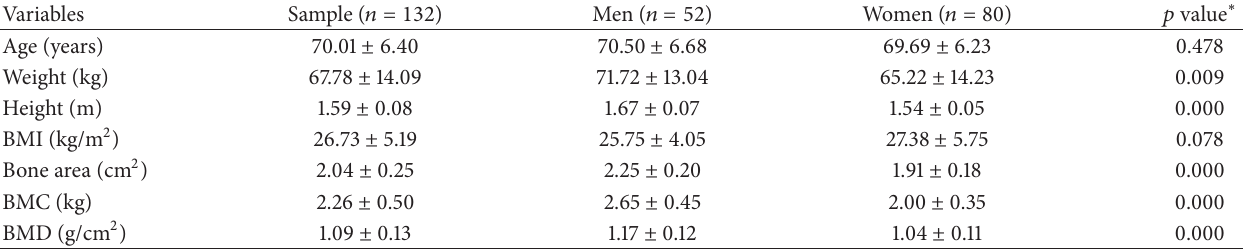
Table 1: Bone mineral density, nutritional parameters, and age of the elderly, by sex. Goiˆania, GO, 2009. 𝑛 = 132 .